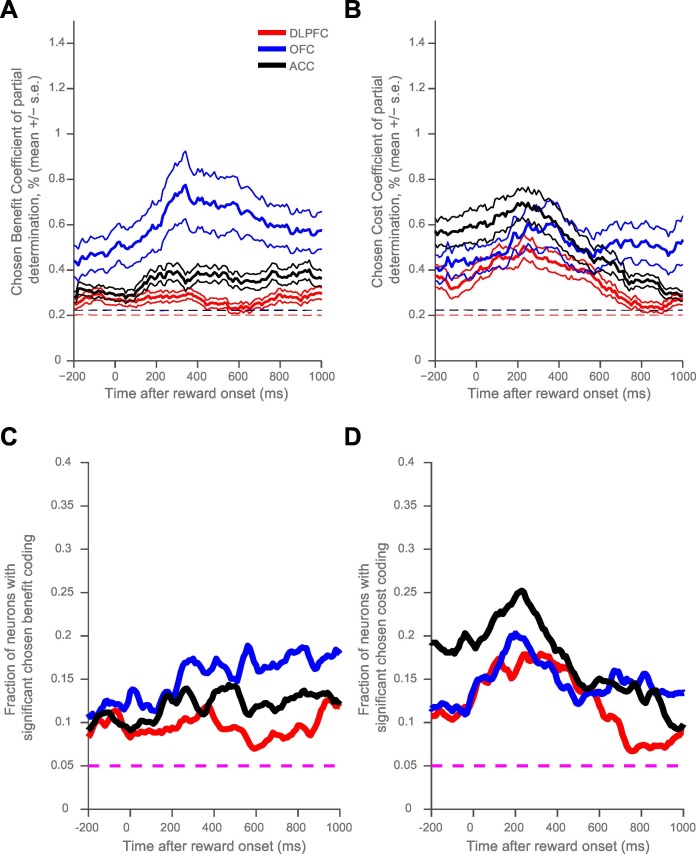
Orbitofrontal cortex codes chosen value, as opposed to chosen benefit alone, at the time of reward delivery.The regression analysis from Figure 1 was repeated, with the chosen value predictor split into chosen benefit and chosen cost components for each trial. Both chosen benefit and chosen cost coding are present at the time of reward delivery. (A) and (B) plot the population average coefficient of partial determination for the chosen benefit and cost regressors timelocked to reward onset. Dashed lines mark the null hypothesis level for CPD in each cortical area (see Materials and methods). (C) and (D), as in Figure 1—figure supplement 1, show the fraction of neurons coding chosen benefit (C) or cost (D) within each cortical area. The dashed magenta lines indicate the null hypothesis fraction of significant coding neurons.